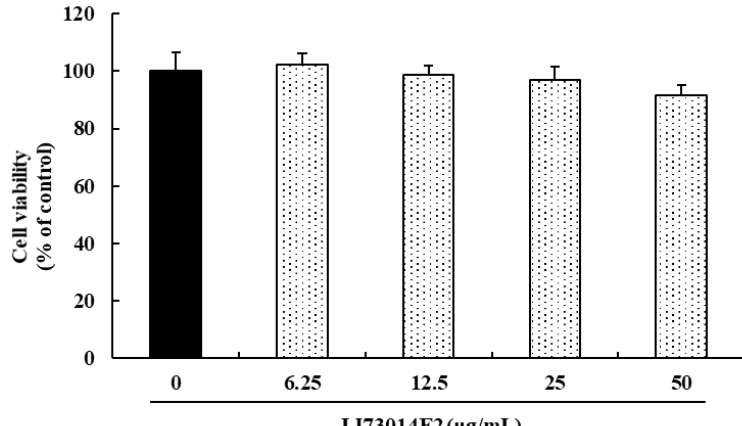
Figure 1. Effect of LI73014F2 on cell viability in Human articular chondrocytes (HCH cells). HCH cells were treated with increasing concentrations of LI73014F2 (0, 12.5, 25 and 50 μg/mL) for 24 h. The cell viability was evaluated using the 3-[4, 5-dimethylthiazol-2-yl]-2, 5 diphenyl tetrazolium bromide (MTT) assay.